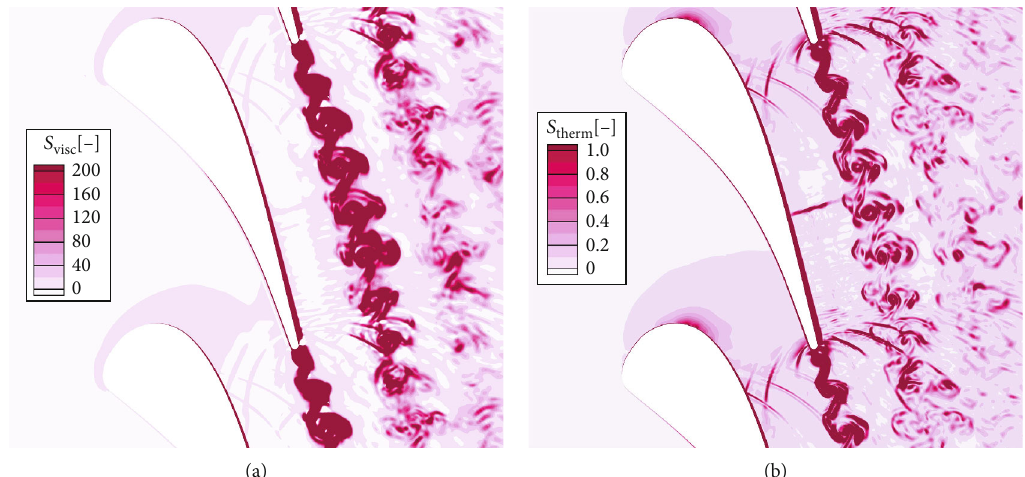
Figure 15: Comparison of local losses due to viscous and heat-transfer e ff ects (MUR235): (a) viscous entropy generation rate; (b) thermal entropy generation rate.